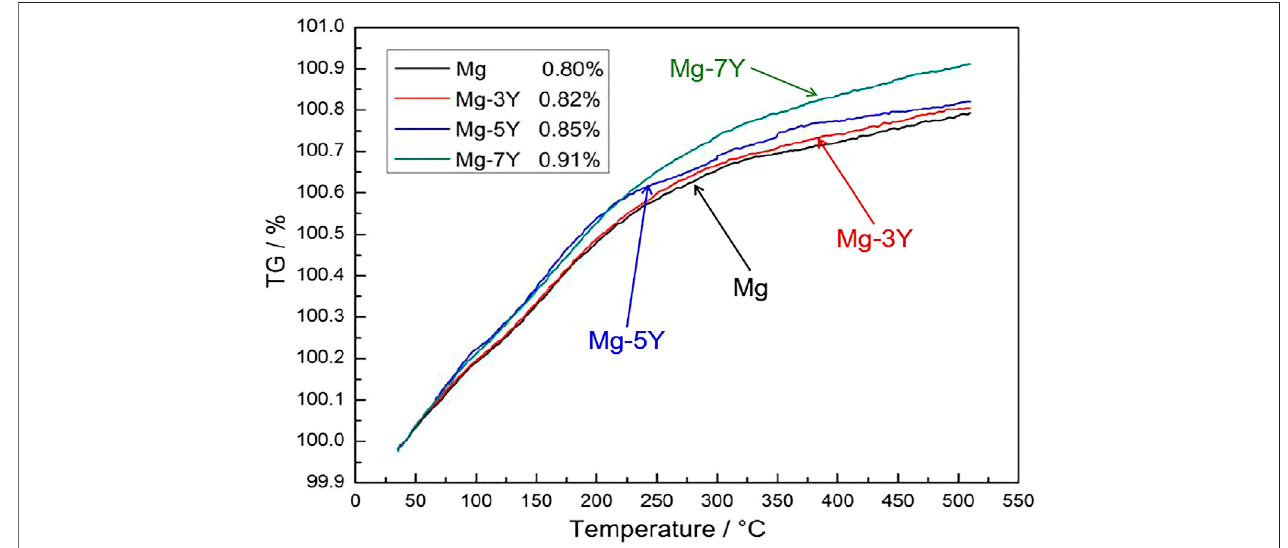
FIGURE 2 | The thermo gravimetric analysis results of different samples.